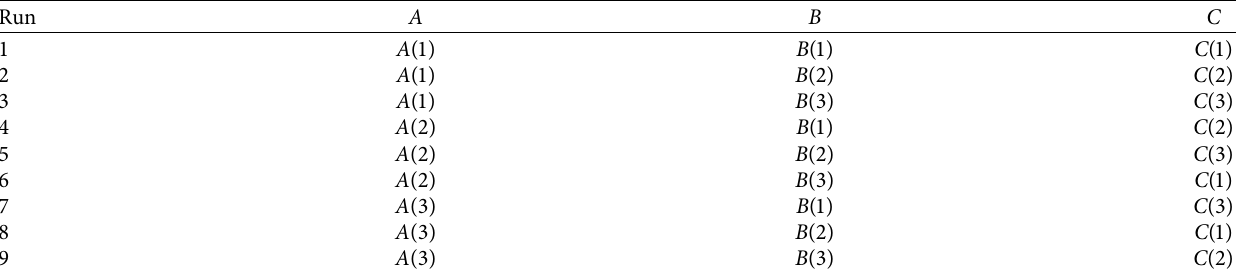
Table 1: Taguchi’s orthogonal arrays matrix (GA).